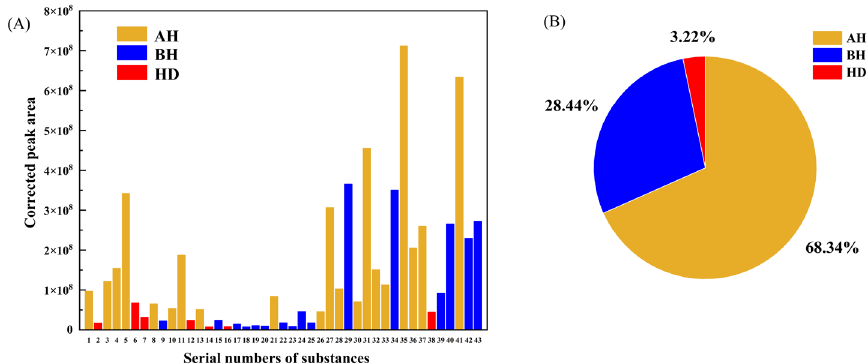
Figure 6. VOCs components from matrix asphalt: ( A ) Highly matched VOCs; ( B ) Proportion of asphalt VOC types.